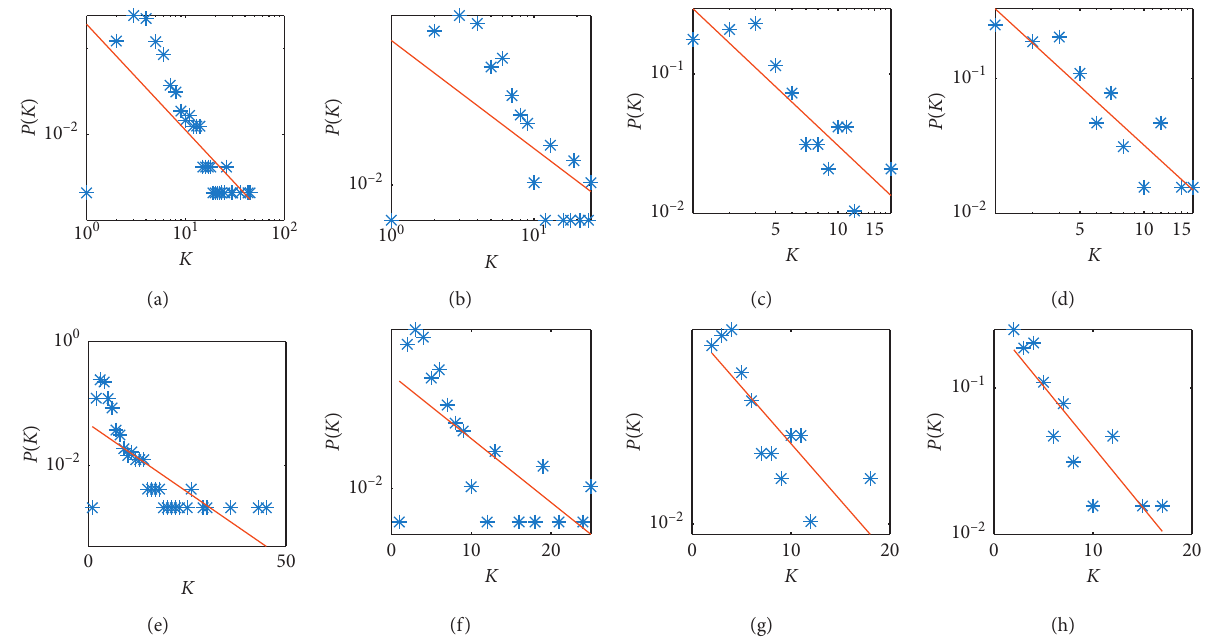
Figure 12: Results after power law distribution and exponential distribution fitting. (a) Δ t � 2min. (b) Δ t � 5min. (c) Δ t � 10min. (d)